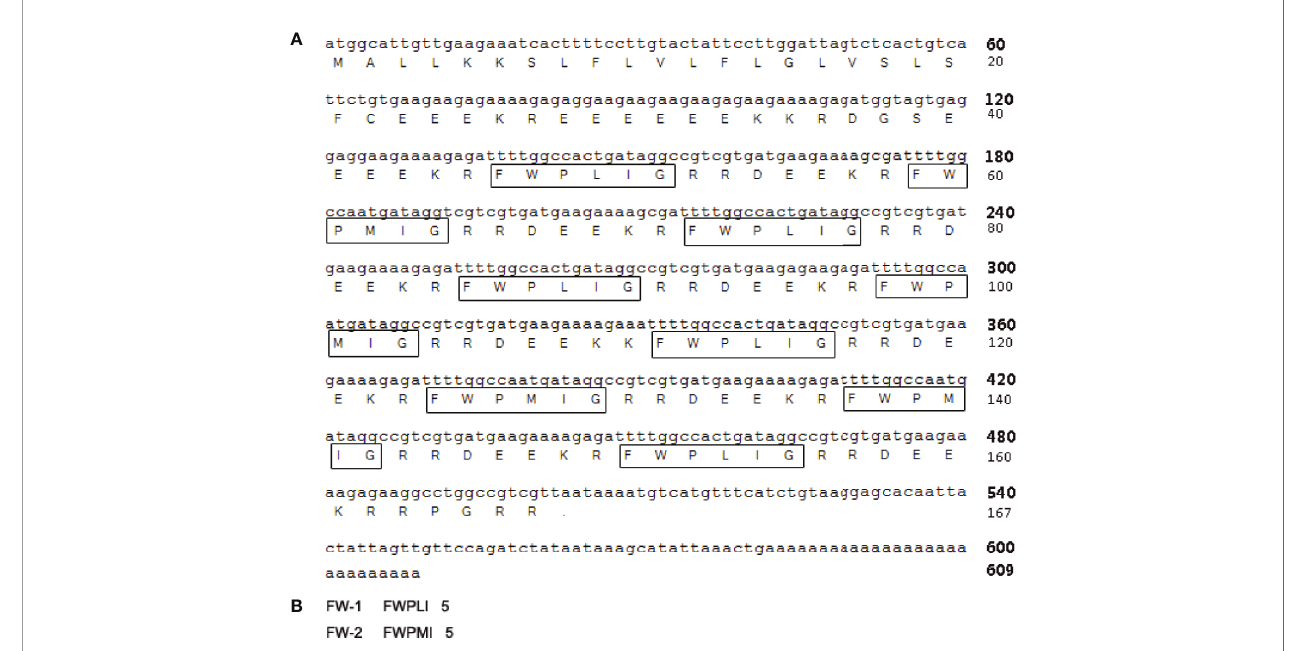
FIGURE 2 | The nucleotide sequence encoding FW-1/2 precursor and the amino acid sequence. (A) The cDNA sequence encoding FW-1 and FW-2 from the skin of tree frog H. annectans . The mature FW-1 and -2 are boxed. (B) The amino acid sequences of mature FW-1 and